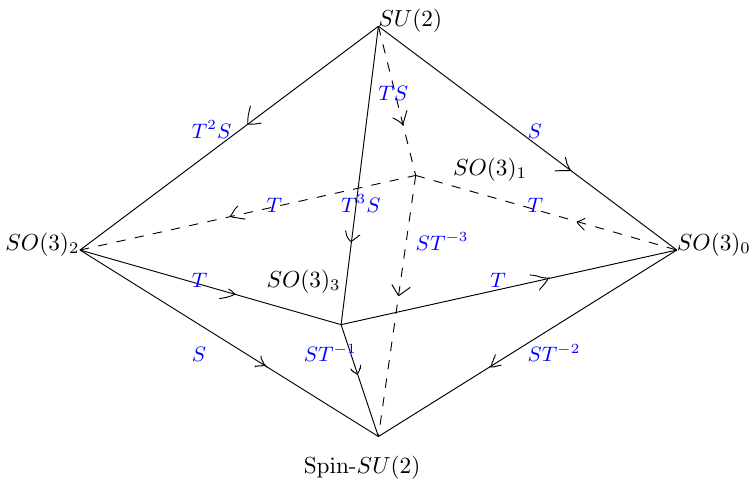
Figure 5 . Six theories permuted by PSL(2 , Z 4 ) arranged as vertices of an octahedron. PSL(2 , Z 4 ) then acts as orientation preserving isometries of the